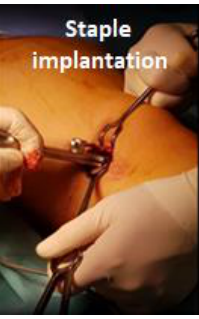
Figure 2. ( a ) Long radiogram of preoperative genu valgum and ( b ) consecutive correction with staples in femur; see [4].